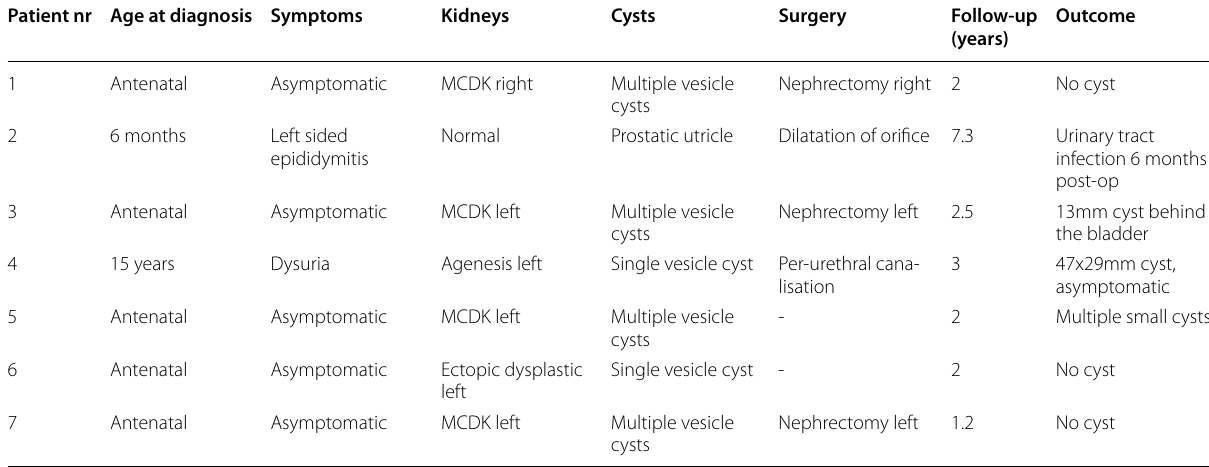
Table 1 Patient characteristic, interventions, and outcomes (MCDK, multicystic dysplastic kidney) Patient nr Age at diagnosis Symptoms Kidneys Cysts Surgery Follow-up